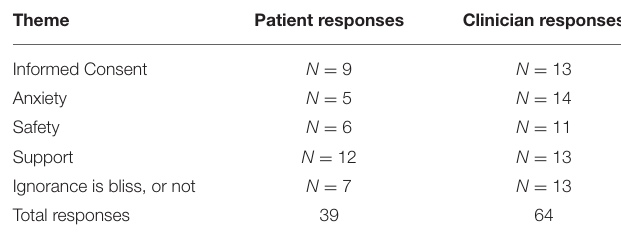
TABLE 2 | Frequency of